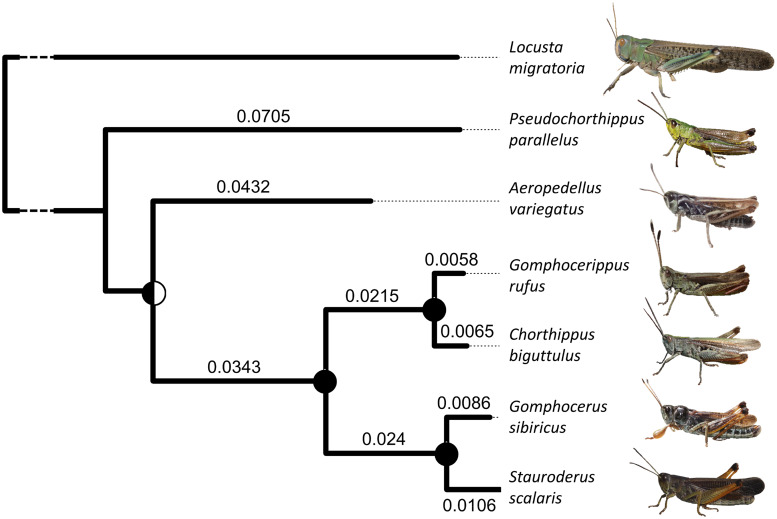
Phylogenetic relationships among six species of gomphocerine grasshoppers (tree rooted using Pacris xizangensis as an outgroup) with Locusta migratoria, a species used for comparison in some analyses, added with unestimated branch length (the divergence time from gomphocerine grasshoppers is ∼61 Ma, Song et al. 2015). This phylogeny was based on mitochondrial markers (using COI, COII, and COIII genes). Numbers show branch lengths and pie charts at nodes show bootstrap support. The topology is congruent with COI mitochondrial sequence-based analyses published by Vedenina and Mugue (2011) and Dumas et al. (2010).